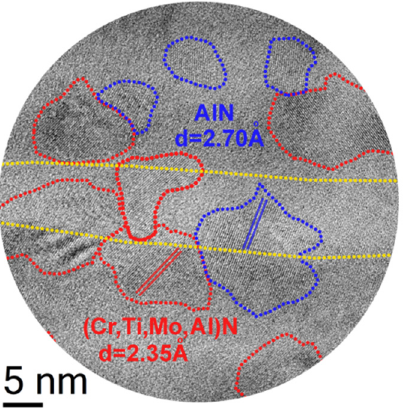
Figure 5. Crystalline structure of coating Ti-TiN-(Ti,Cr,Mo,Al)N (HR TEM).